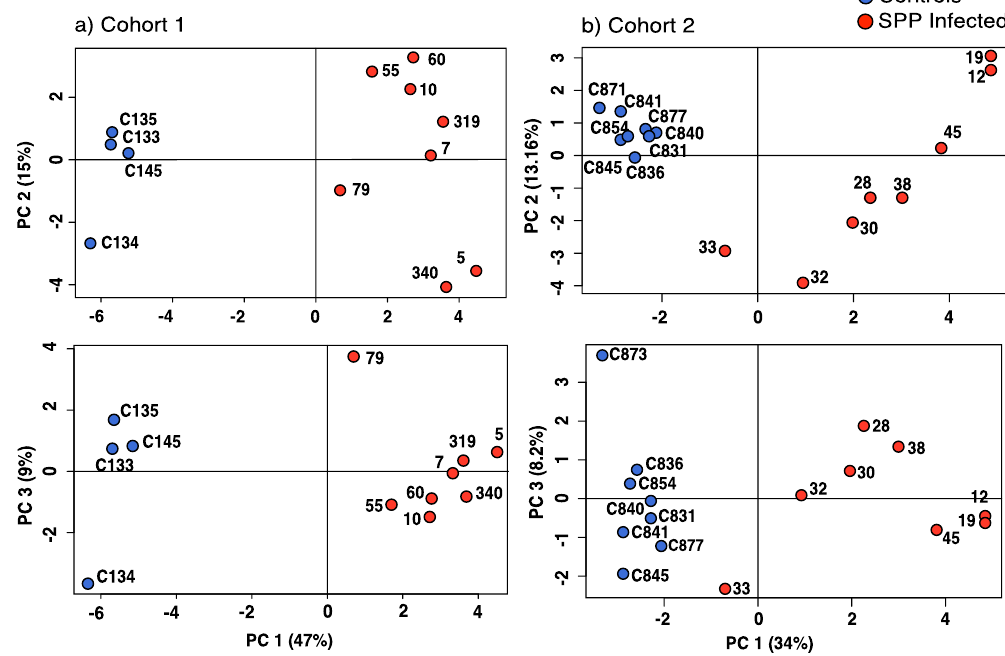
Figure 4. Principal component analysis of CSF proteomes. The quantitative proteome profiles obtained by label-free analysis using Progenesis QI were used to inform a principal components analysis in R. To correct for loading variance, each log protein summed intensity was normalised and expressed as z-score within the CSF sample. (Panel a) shows the result for the first cohort and (Panel b) for the second cohort. Control samples are defined by blue symbols, infected samples by red symbols.